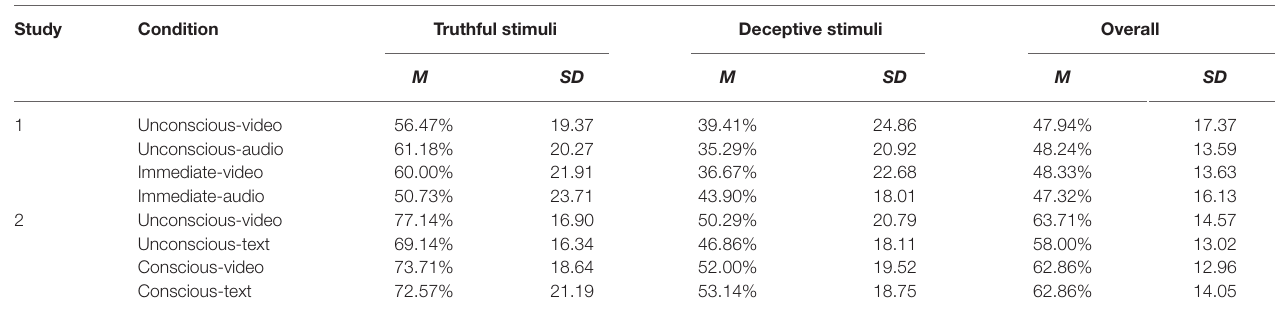
TABLE 1 | Means and standard deviations of accuracy for all conditions in Study 1 and 2.